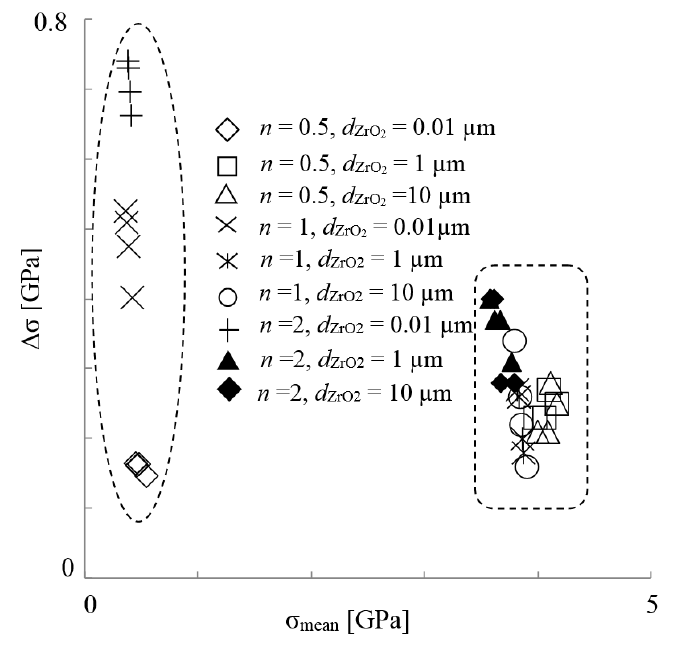
, in ZrO 2 surface layer during thermal Figure 8. Maximum equivalent thermal stresses, σ eq max for d ZrO = 0.01 μ m; ( b ) σ eq for d ZrO = 10 μ m. shock cycling. ( a ) σ eq max max 2 2 Amplitudes (ranges) of thermal stresses, Δσ , plotted against mean stresses, σ mean are shown in Figure 9. The data can be classified into two regimes. It can be seen that in case of high creep rates of = 0.01 μ m), the values of σ mean are very low compared to values for low creep rates of ZrO 2 ZrO 2 ( d ZrO 2 ( d ZrO = 1 and 10 μ m). 2